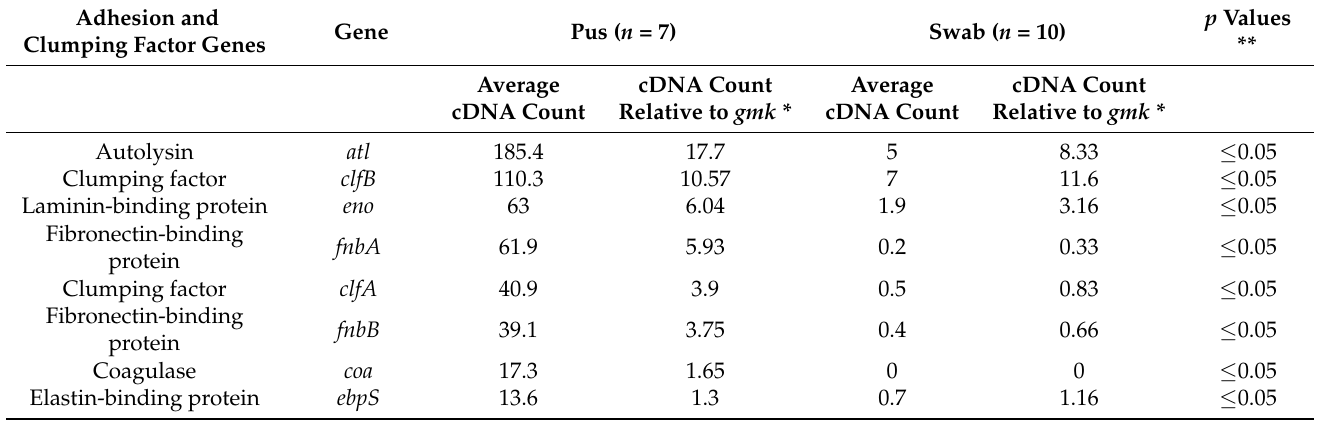
Table 3. The average cDNA count of the adhesion and clumping factor genes from pus or swab samples and their relative cDNA count to that of gmk .